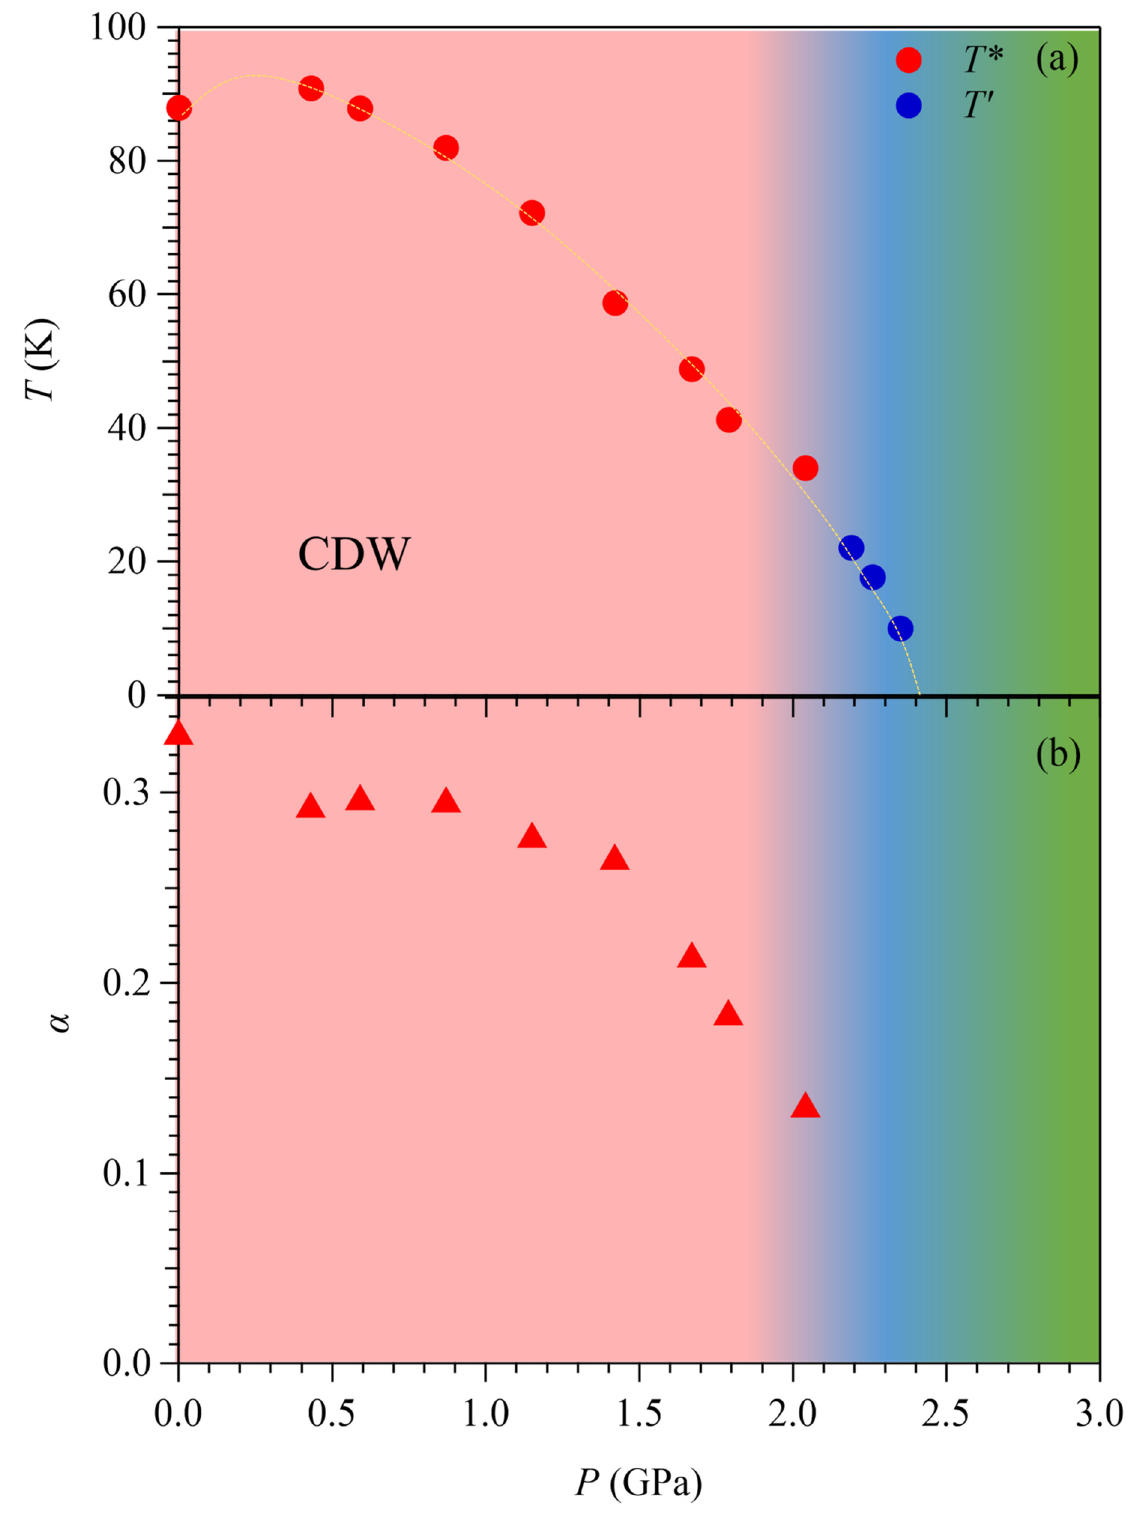
Figure 3. ( a ) Pressure dependences of T * (red) and T ’ (blue) for ScV 6 Sn 6 as determined from the high- pressure resistivity measurements. ( b ) Pressure dependences of the parameter α .